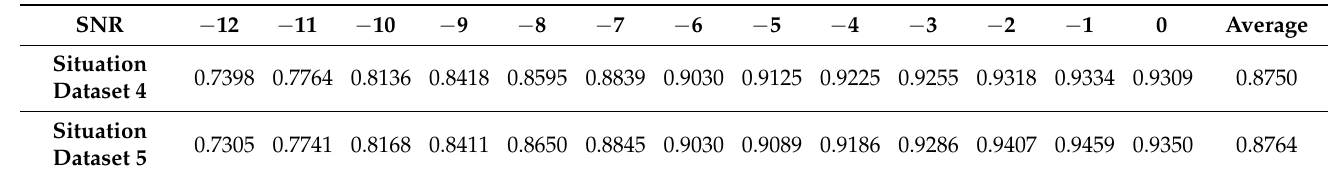
Table 6. The semi-supervised classification accuracy of our proposed method for SNR with the datasets in Situation Dataset 4 and Situation Dataset